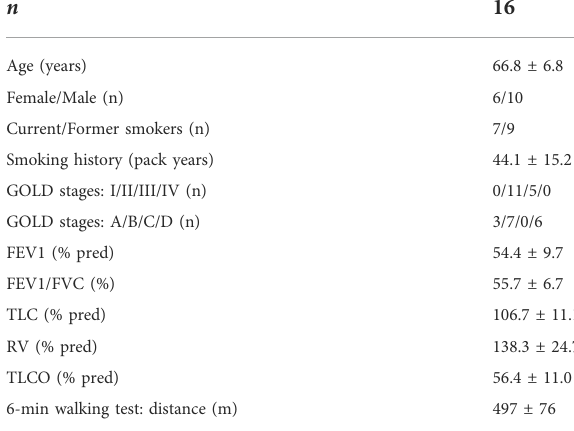
TABLE 1 Clinical characteristics of patients with